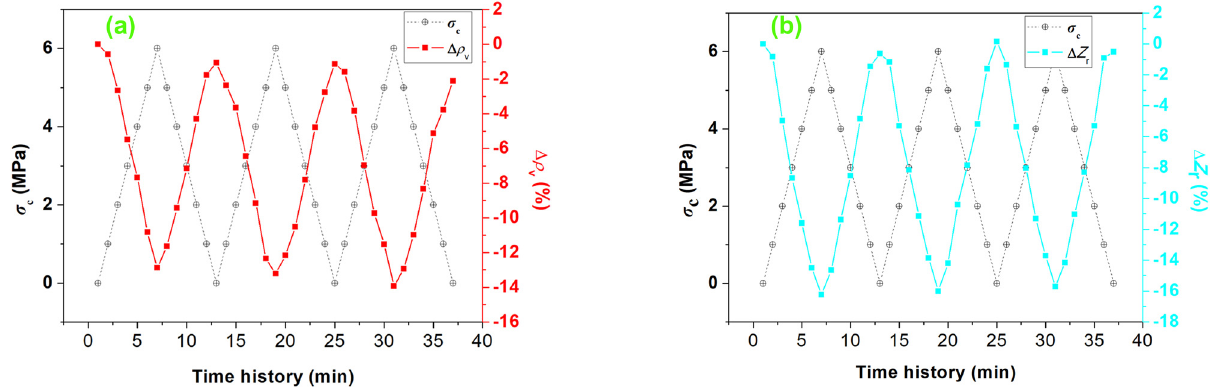
Figure 6: The piezoresistive curves of MNT/CM: ( a ) Δ ρ v − σ c relation; ( b ) Δ Z r − σ c relation.